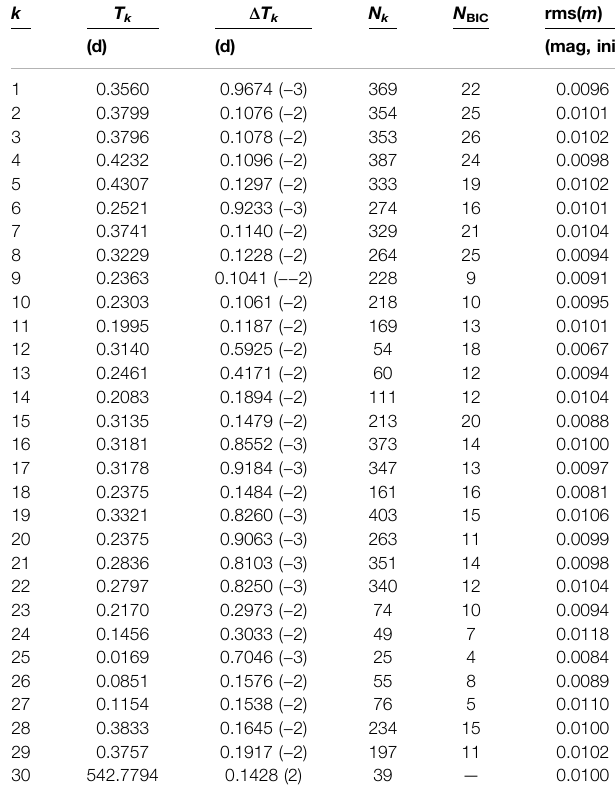
TABLE 5 | Lightcurve characteristics for the simulated GS-asteroid. First, we give the lightcurve identi fi er ( k ), time span ( T k ), mean sampling time interval ( Δ T k ), and number of observations ( N k ). Second, we give the number of nodes for the cubic spline fi t based on the Bayesian information criterion ( N BIC ) and the rms- value of the spline fi t in relative magnitude (rms( m )). In the third column, for example, 0.9674 ( − 3) stands for 0.9674 × 10 – 3 .